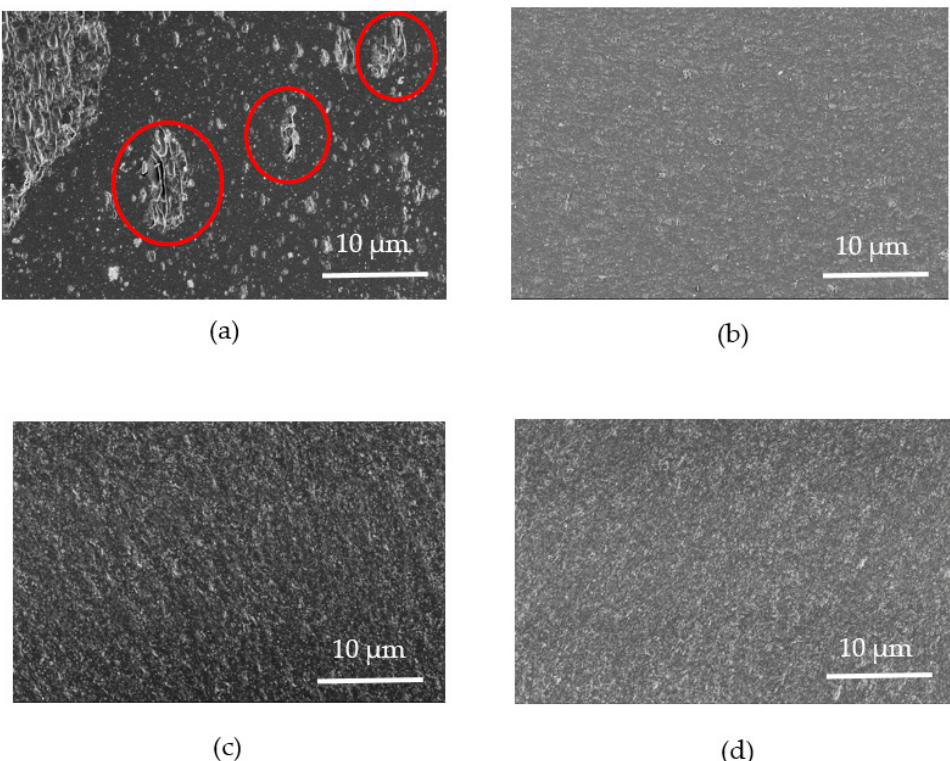
Figure 7. Scanning electron micrographs of BR–lignin composites with varying lignin concentration. The lignin concentrations are ( a ) 30, ( b ) 50, ( c ) 70, and ( d ) 90 phr. Red circles are highlighting the agglomerates present in the composite having a lower concentration of lignin.